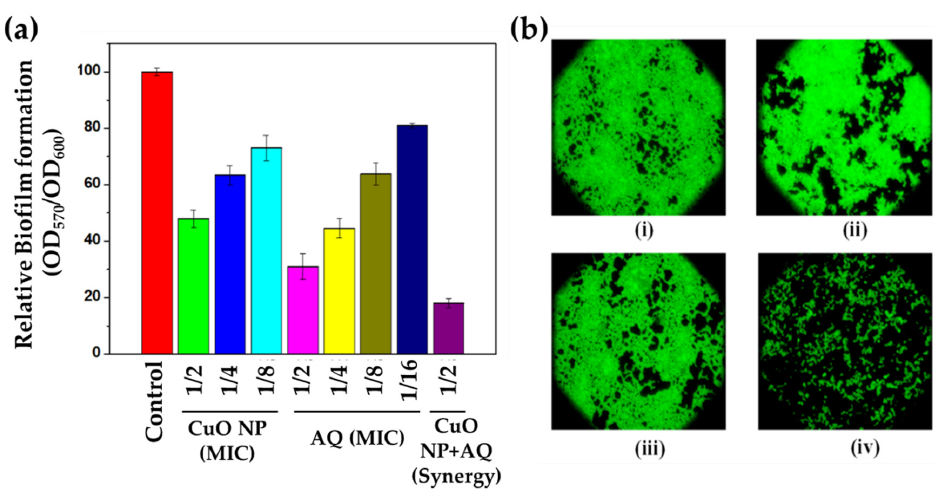
Figure 7. Effects of synergy on biofilm formation. ( a ) Relative biofilm formation (OD 570 /OD 600 ) was determined for S. aureus (ATCC 25923) cells under the absence or presence of samples at MIC or half of the synergistic level. C, control; CuO NPs (1/2, 1/4, or 1/8 MIC)]; AQ (1/2, 1/4, 1/8, or 1/16 MIC); CuO NPs/AQ (1/2 synergy)]. The values in the graph represent the average ± SD ( n = 7). ( b ) Microscopic analysis of biofilm architecture of S. aureus ATCC 25923 cells. ( i ) Control, ( ii ) CuO NPs (1/8 MIC), ( iii ) AQ (1/16 MIC), and ( iv ) CuO NPs/AQ (1/2 synergy).